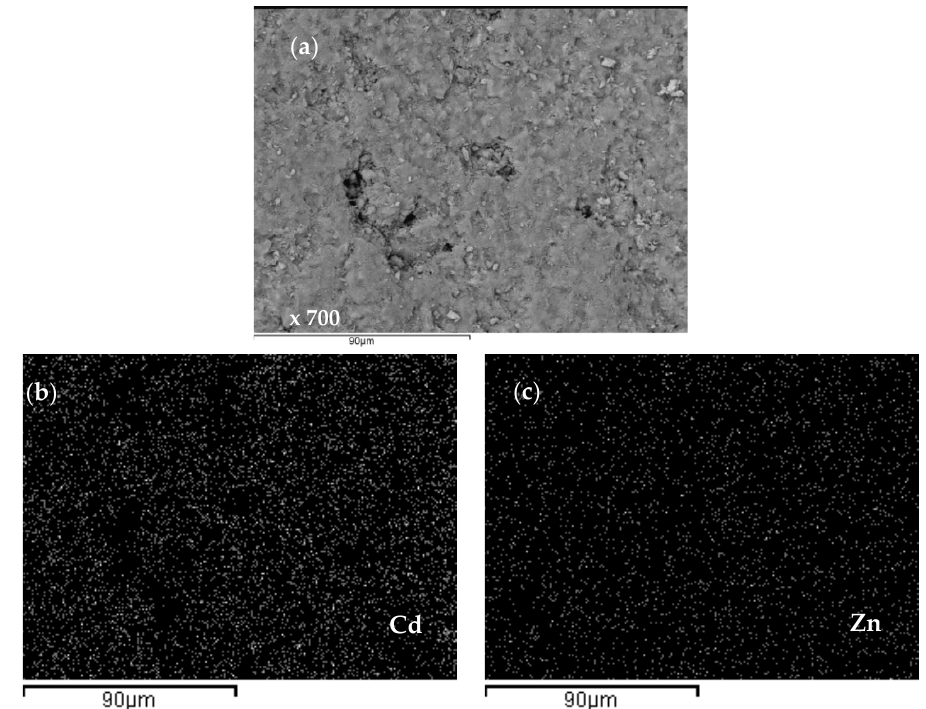
Figure 19. ( a ) An SEM image of the surface on a zeolite grain for the (Cd + Zn) system and Cd/Zn = 1.07, ( b , c ) a mapping analysis of the surface with a mean wt.(%) of 5.61 Cd and 3.52 Zn.